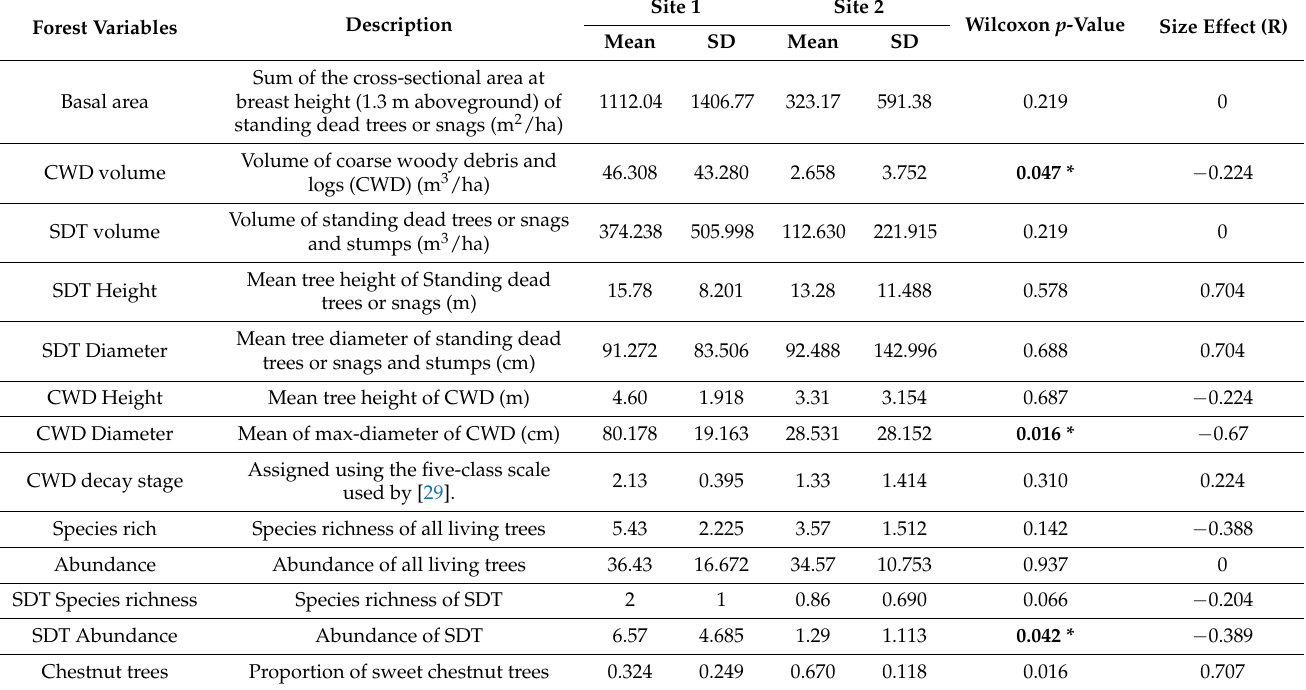
Table 2. Thirteen environmental variables collected in the field to characterize the plot area surround- ing each window trap. CWD stands for Coarse Woody Debris, while SDT stands for Standing Dead Trees. 0.01 < * p -value ≤